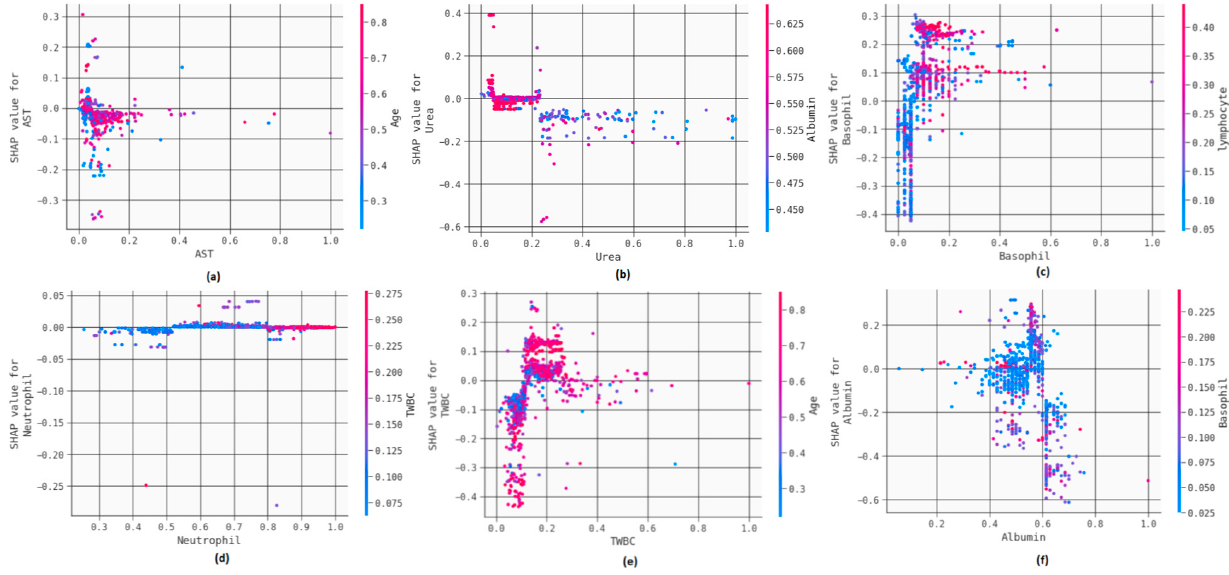
Figure 10. SHAP dependence plots of some clinical markers. ( a ) AST, ( b ) urea, ( c ) basophil, ( d ) neu- trophil, ( e ) TWBC, and ( f ) albumin.